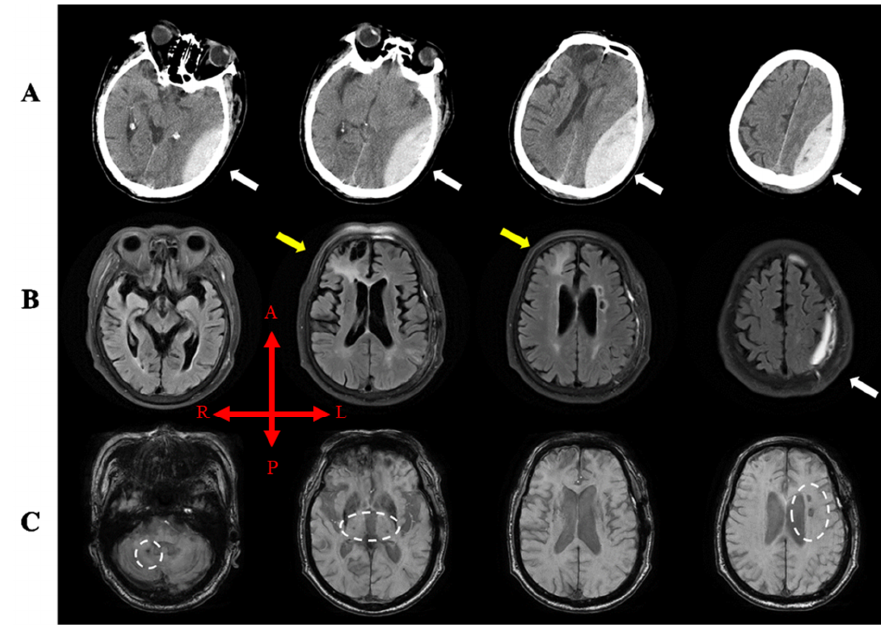
Figure 1. ( A ) Computed tomography (CT) images showing EDH caused by TBI (white arrow). ( B ) Magnetic resonance T2 FLAIR image four weeks after onset showed encephalomalacia due to contusion hemorrhage in the right frontal lobe (yellow arrow) and increased SDH in the left frontal and parietal lobes (white arrows). ( C ) Multiple petechial hemorrhages with diffused axonal injury on GRE images were observed in right cerebellum, pons, both thalami, both basal ganglia, and left temporal lobe (white dashed circle). Note: EDH, epidural hematoma; TBI, traumatic brain injury; FLAIR, fluid attenuated inversion recovery; GRE, T2-weighted gradient recall echo; R, right; L, left; A, anterior; P, posterior .